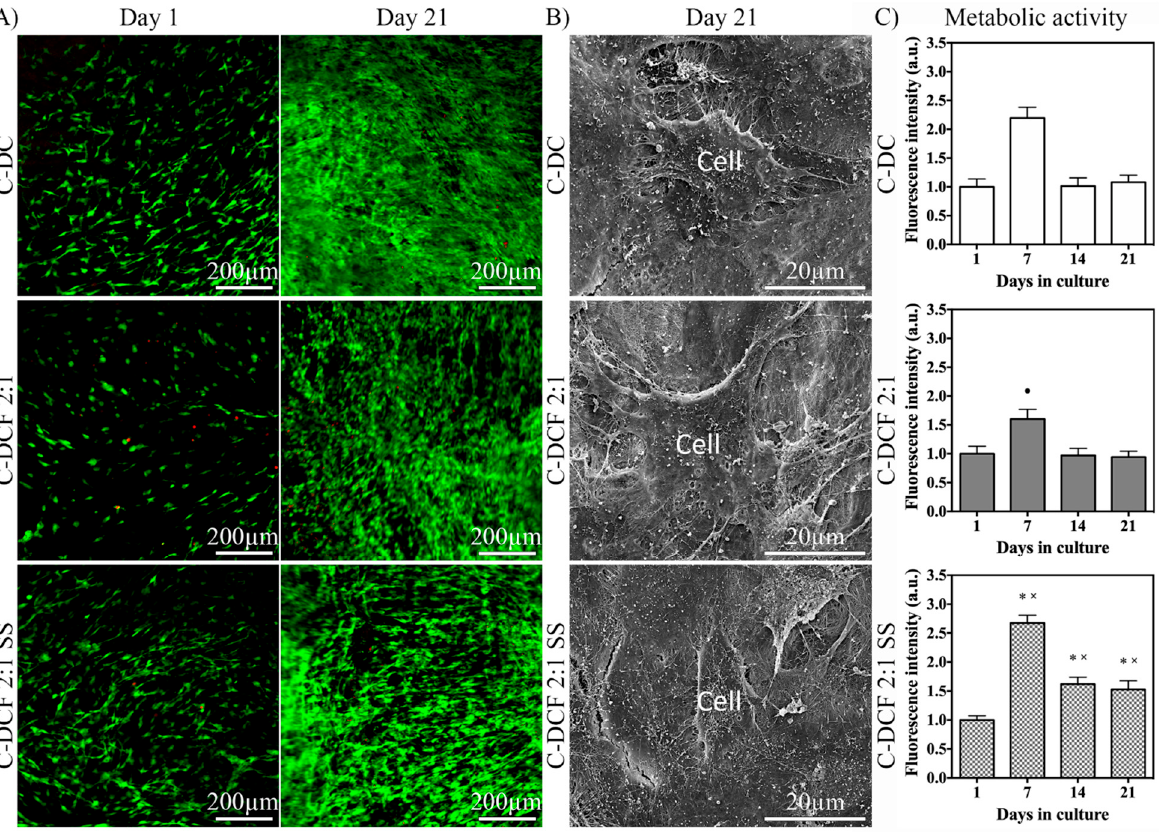
Figure 4. Seeded MC3T3-E1 pre-osteoblast viability, morphology, and metabolic activity under osteogenic medium. ( A ) Live/Dead™ assay of MC3T3-E1 cells cultured in DC, DCF 2:1, and DCF 2:1 SS gels at days 1 and 21. Cells grew both in time and space with negligible mortality and no quali- tative di ff erence among the three gels. ( B ) SEM micrographs of seeded MC3T3-E1 cells. Cells